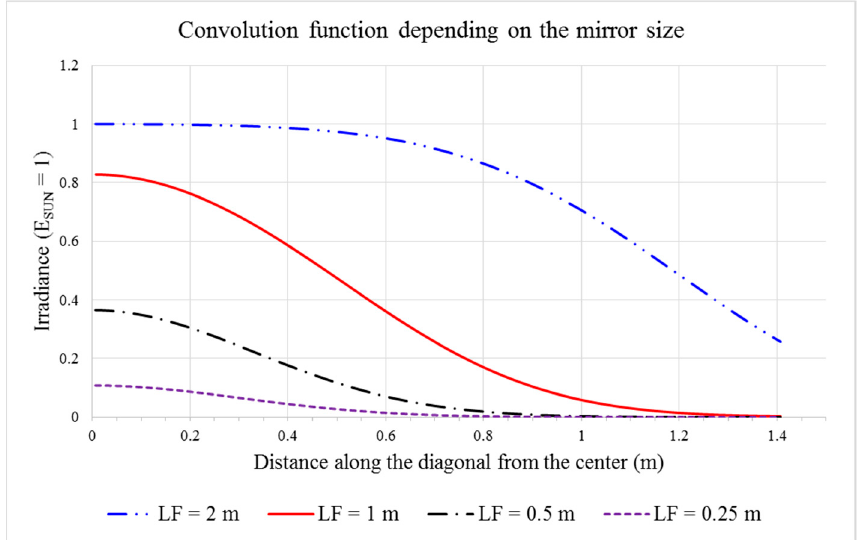
Figure 2. Irradiance E ( x , y ) on the target for a square heliostat with side 2 L F .